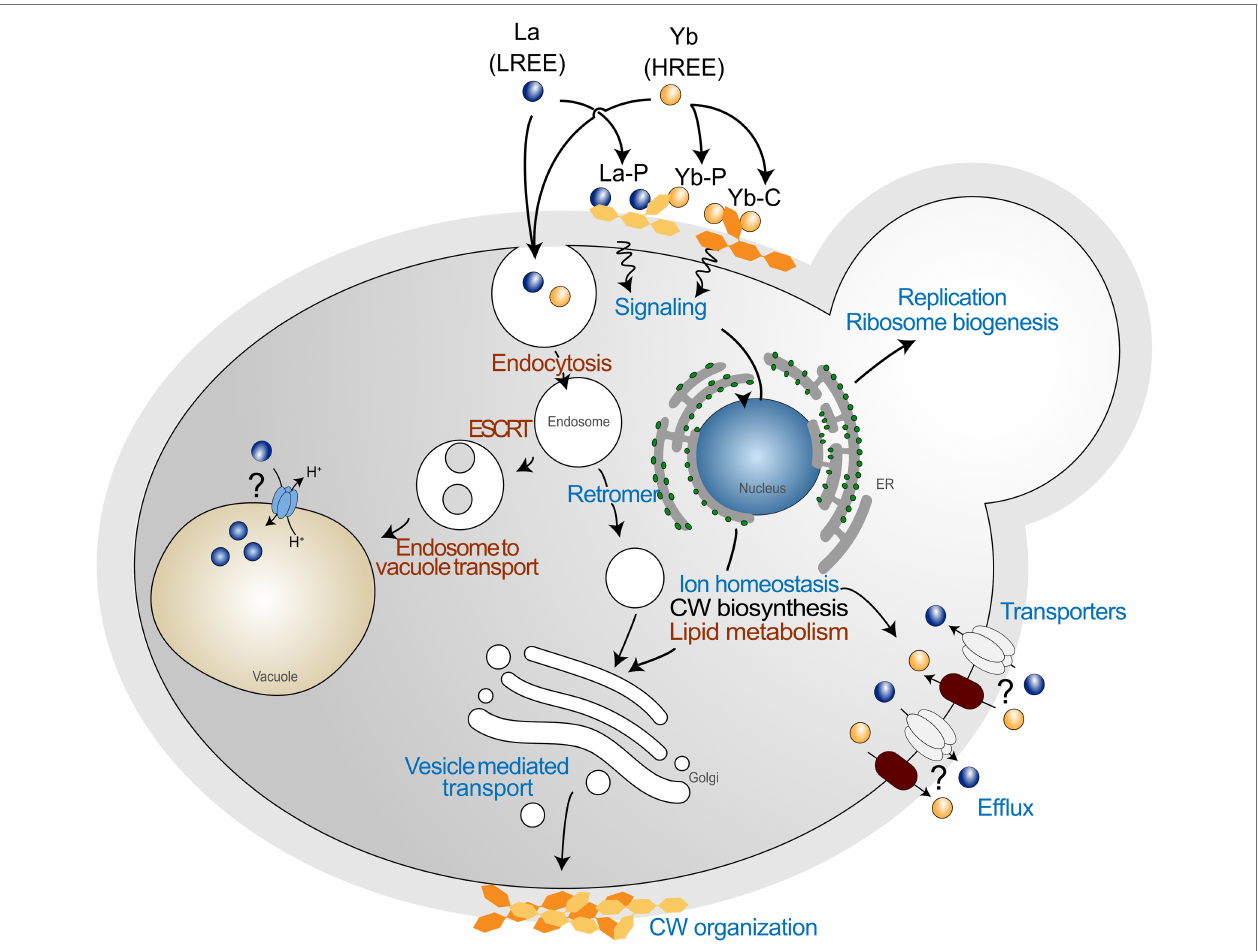
FIGURE 8 | Global pathways in Saccharomyces cerevisiae exposed to lanthanide stress. Schematic representation of general functions identified through mutant collection screening. Common functions between the two lanthanides are shown in red, and functions showing a different behavior are shown in blue. La is representative of LREEs, while Yb is representative of HREEs. La-P and Yb-P represent lanthanum ions bound to phosphate groups, while Yb-C represents ytterbium ions bound to carboxyl